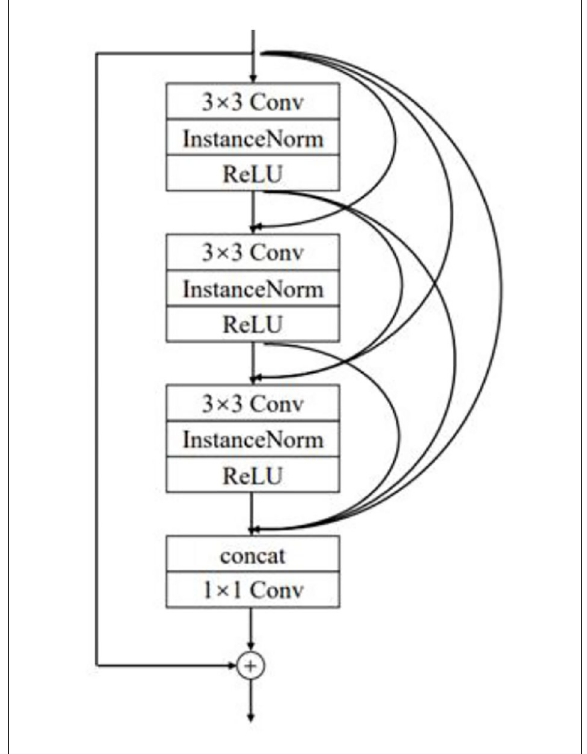
FIGURE4 Schematic diagram of residual dense cell